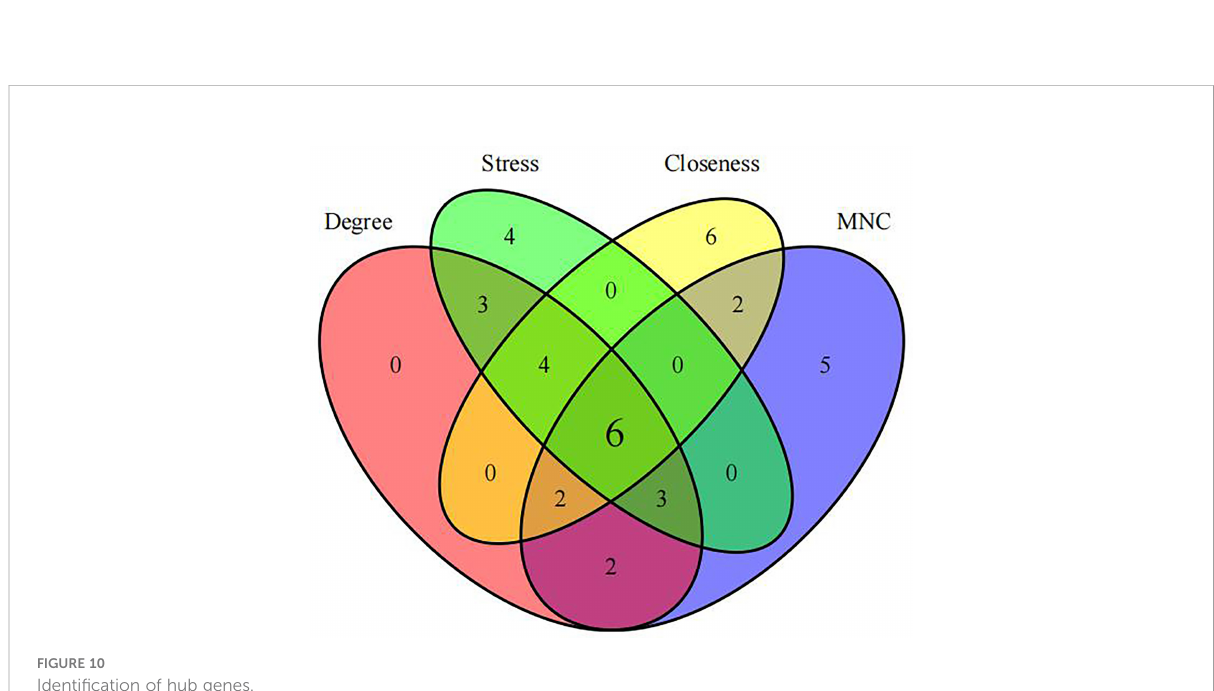
FIGURE 10 Identi fi cation of hub